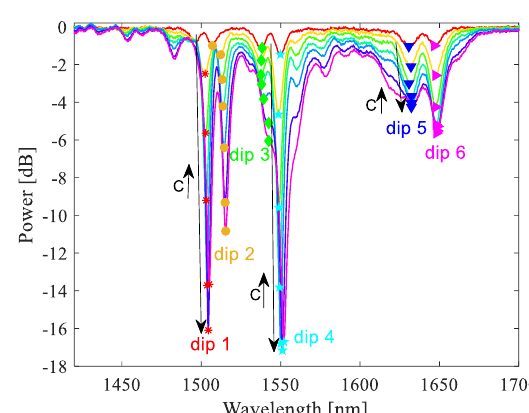
Fig. 2 . Transmission spectra as function of the applied curvature.